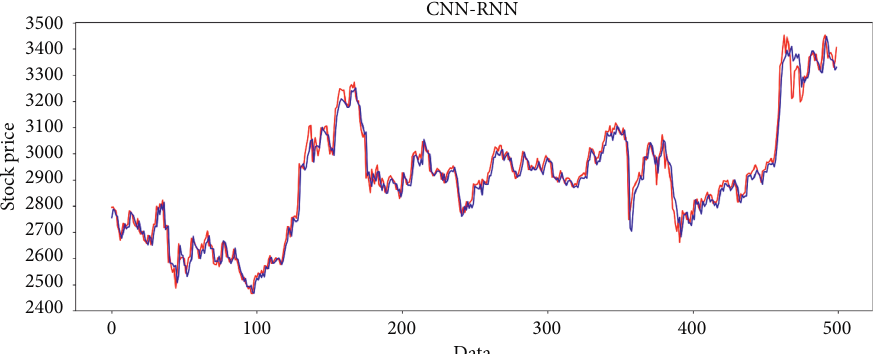
Figure 9: Comparison of the predicted value and the real value for CNN-RNN.